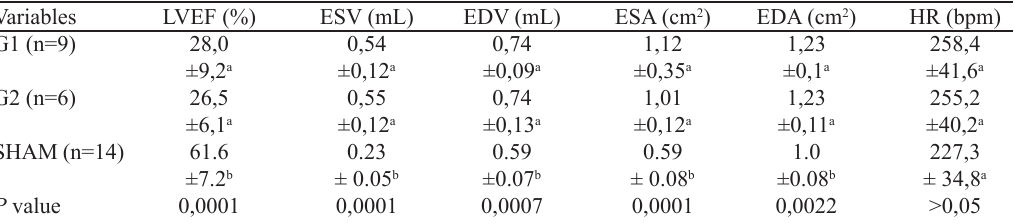
Table 3. Comparison of the means of echocardiographic measurements between the groups SHAM and G2, G1.